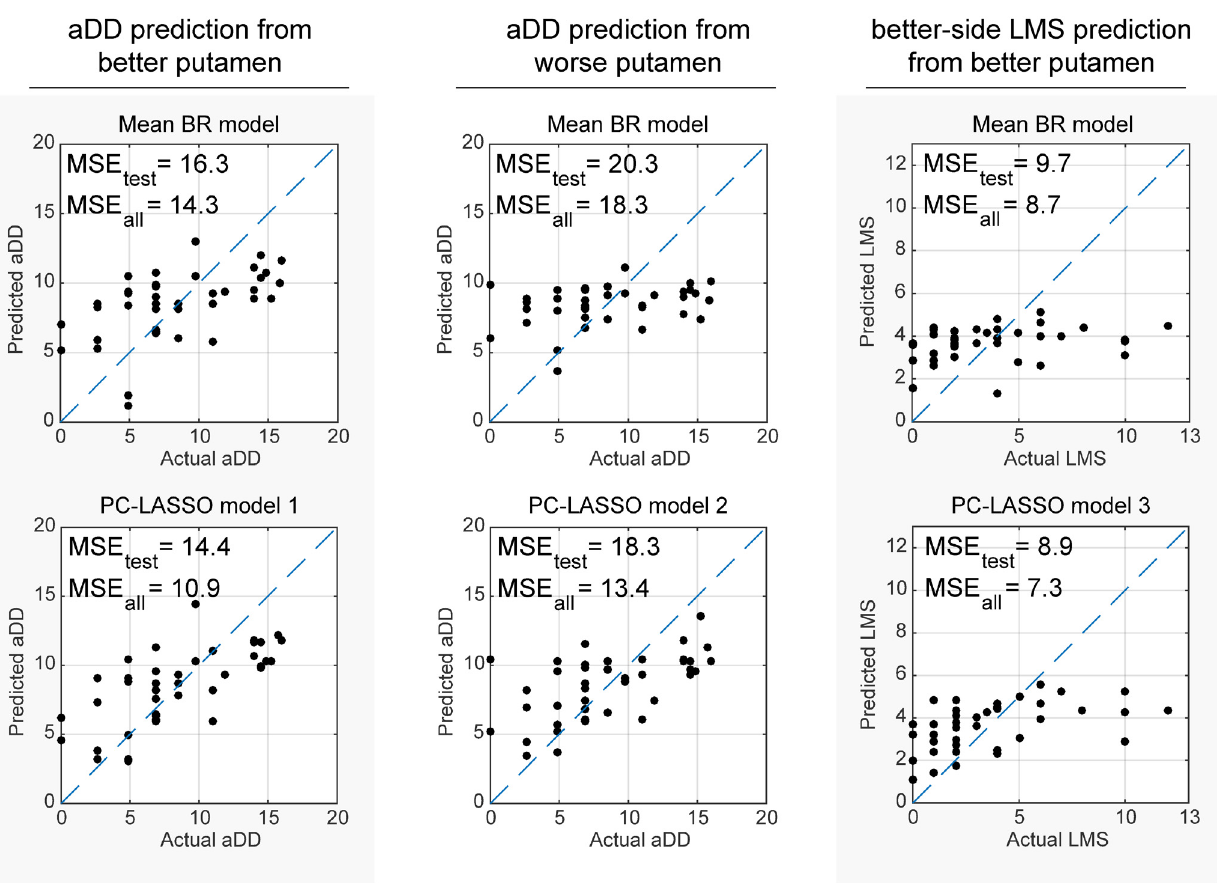
Fig 6. Predicted clinical metrics plotted against the actual metrics. The mean BR model predictions are shown on the top, and the PC-LASSO model predictions are shown on the